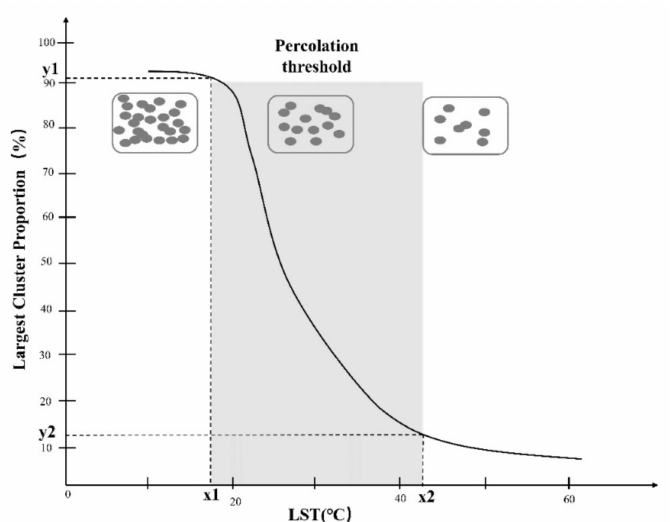
Figure 2. Schematic of the percolation-based clustering method; (x1,y1) and (x2,y2) define the percola tion threshold at which the giant component